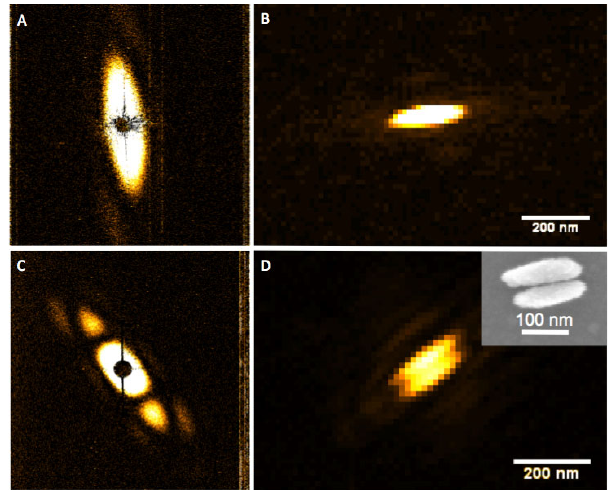
FIG. 5. Single-shot diffraction patterns (FLASH, 7 nm, 10 fs, 10 12 ph = pulse ) and corresponding reconstructed electron density (both linear scales) of (A)-(B) one or (C)-(D) two ellipsoidal iron oxide nanoparticles. In both diffraction patterns the central lobe and a faint first side lobe are detectable against the background. The lack of further side lobes results in weak artifacts in the reconstruction. Pixel dimensions are about 14 nm by 15 nm for (B) and (D), respectively. Inset: Scanning electron microscopy of nebulized particles captured on a silicon wafer, 100 k magnifi- cation.